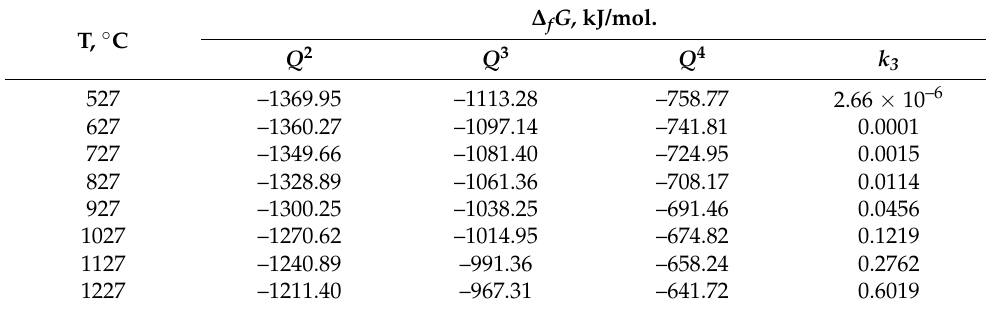
Table 4. Calculated Gibbs free energy values of the formation of Q n structural units of the K 2 O-SiO 2 melt and equilibrium constants of Reaction (1) at n = 3 as a function of